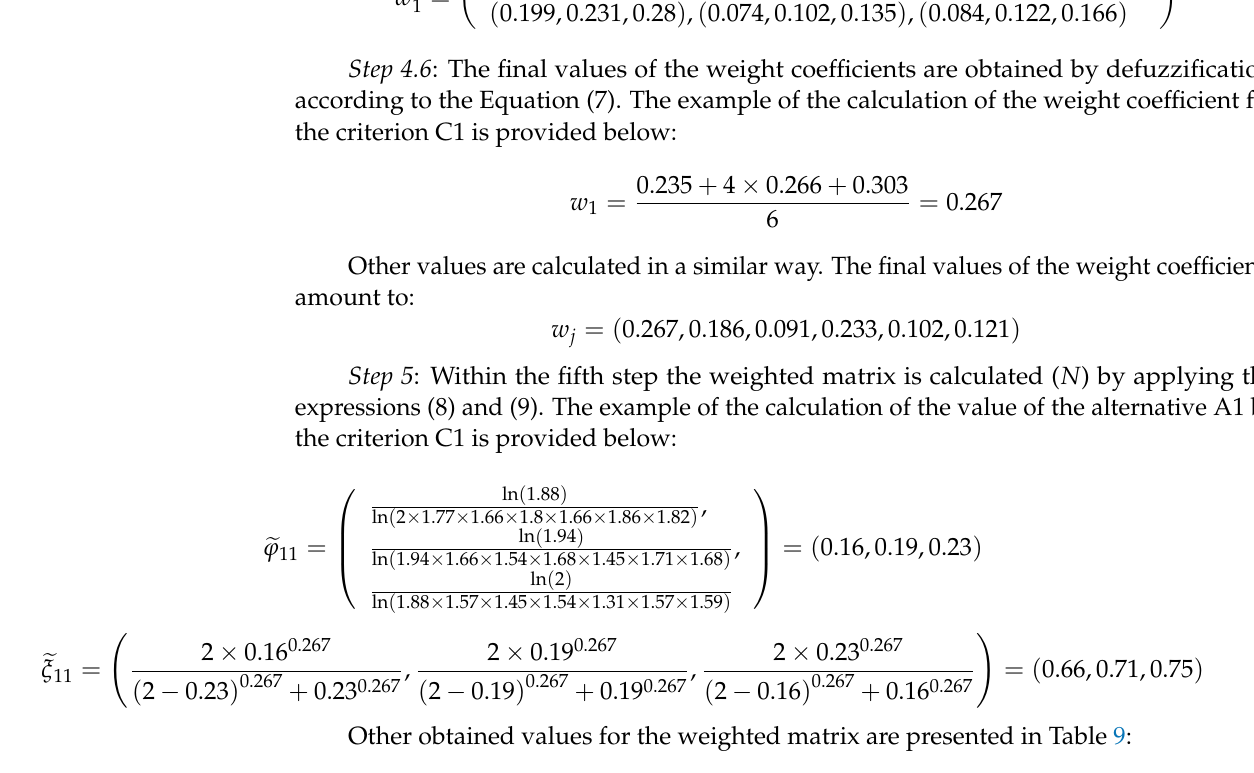
Table 9. Weighted decision-making